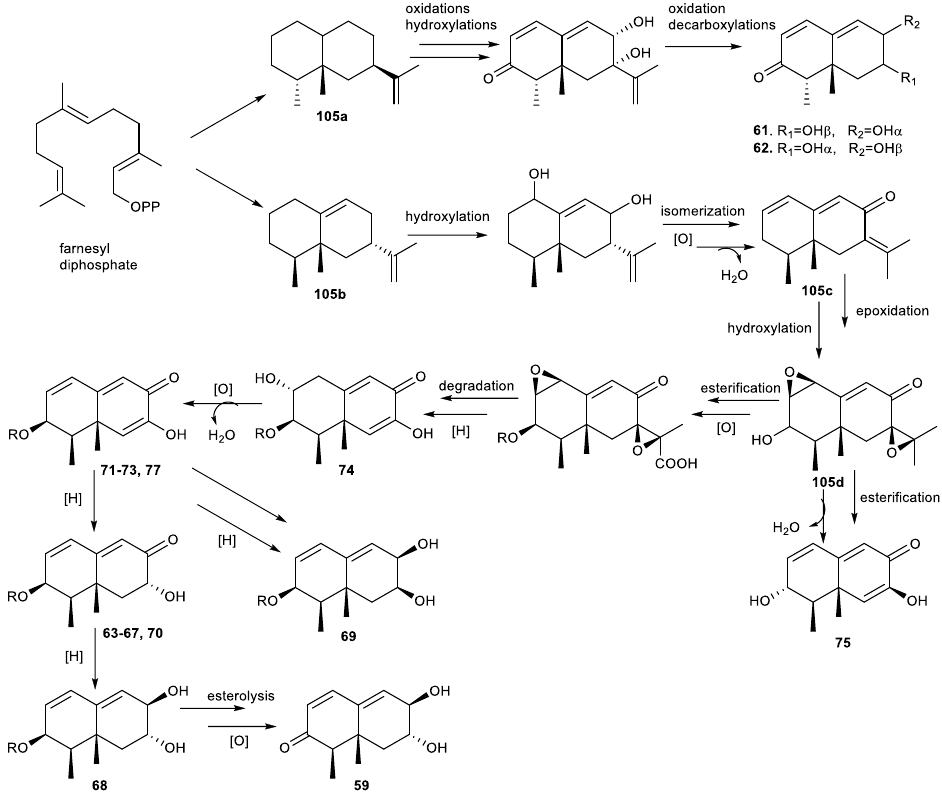
Figure Figure 16. Hypothetical biosynthetic pathways of tri- nor -eremophilanes (adapted from Lin et al. 2021 [214]).